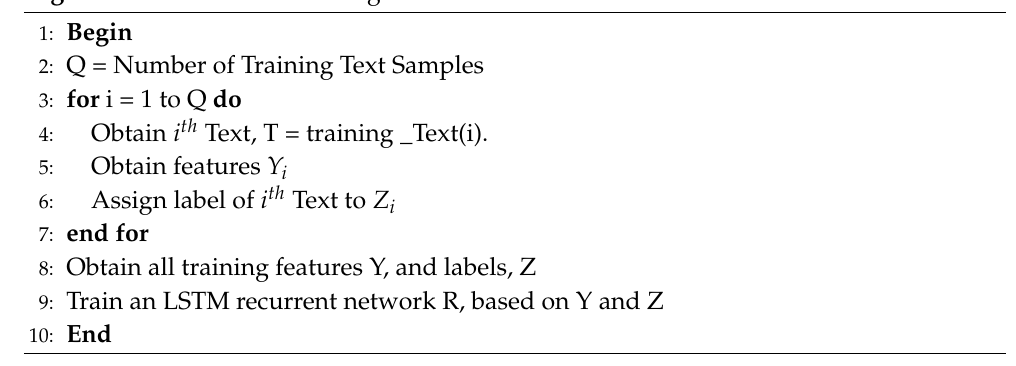
Algorithm 2 Model For Training Text